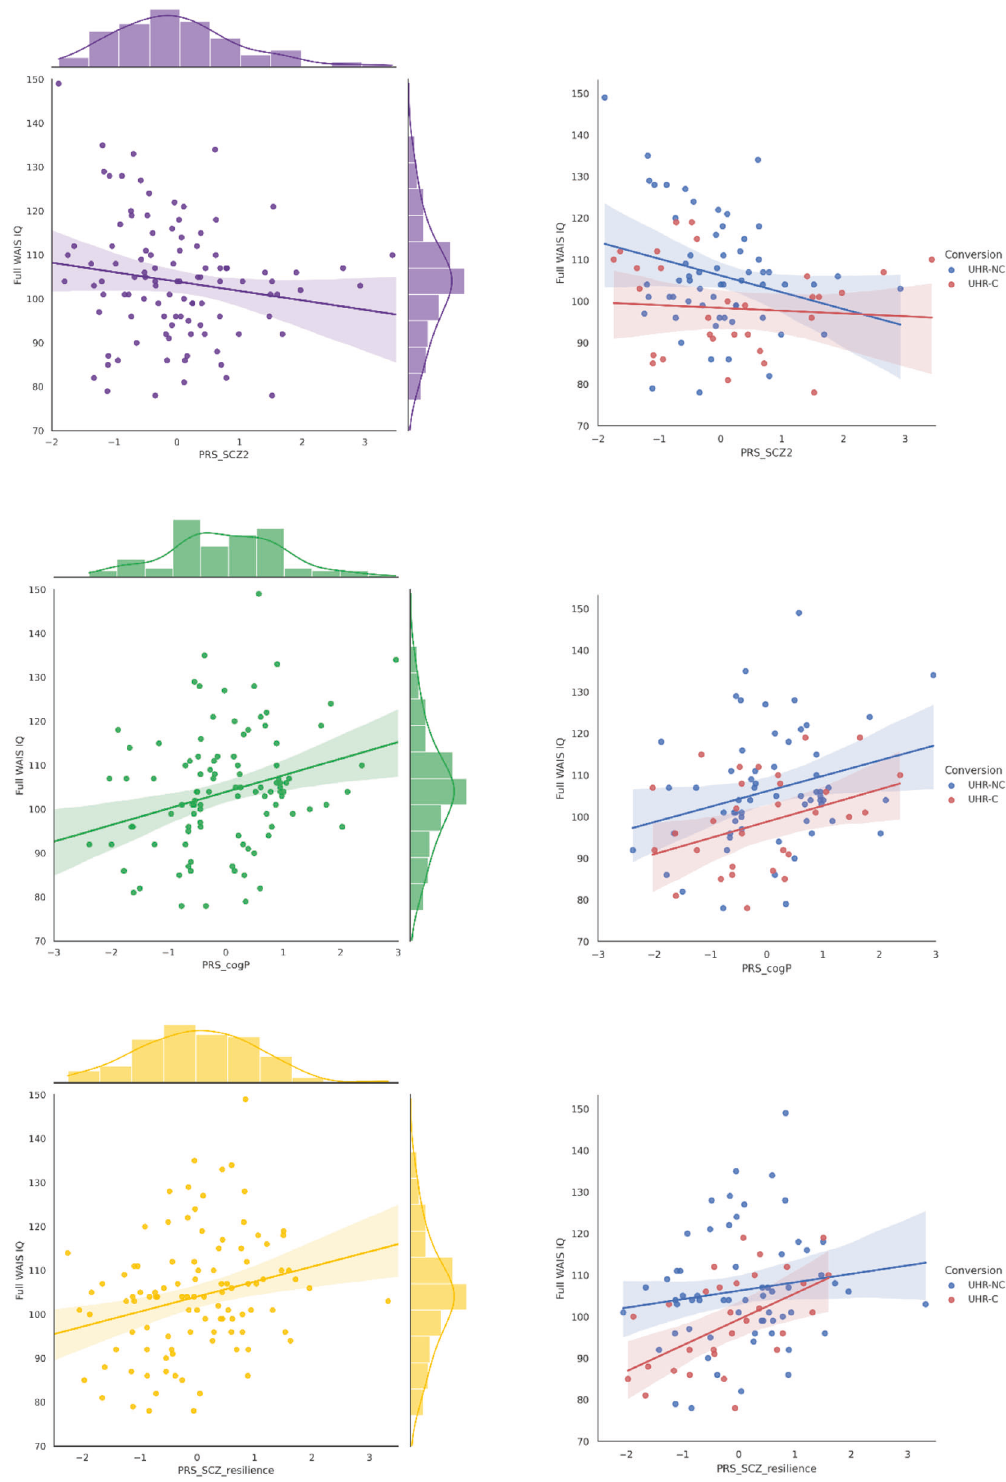
Fig. 2 Linear regression between full WAIS IQ and PRS of schizophrenia, cognitive performance and resilience to schizophrenia. PRS_SCZ2: PRS derived from schizophrenia GWAS; PRS_cogP: PRS derived from GWAS of cognitive performance, PRS_SCZ_resilience: PRS derived from GWAS of resilience to